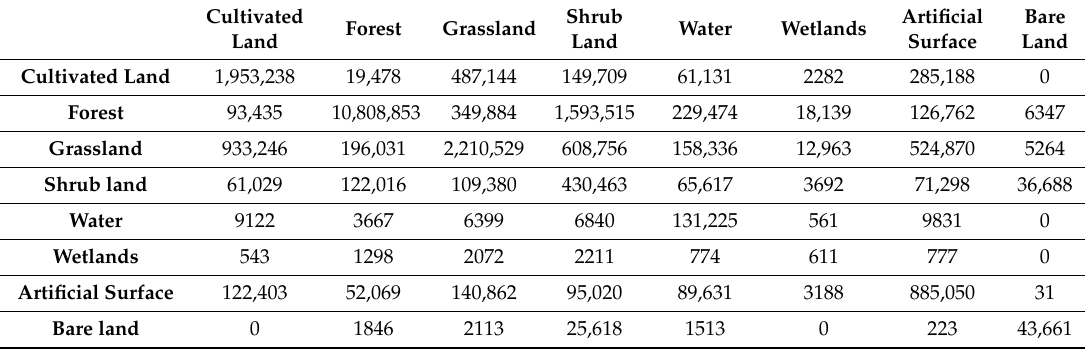
Table 4. Confusion matrix with median frequency class weights (Slovenia—8 classes).